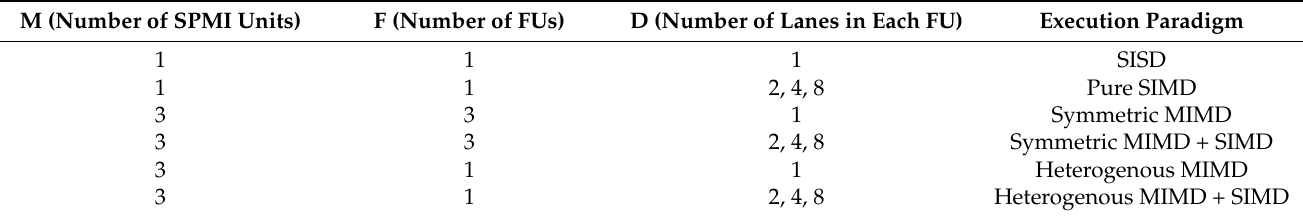
Table 1 summarizes the design parameters and corresponding configurations, whose names will be used as references in reporting performance results. Table 1. Summary of explored hardware configurations.